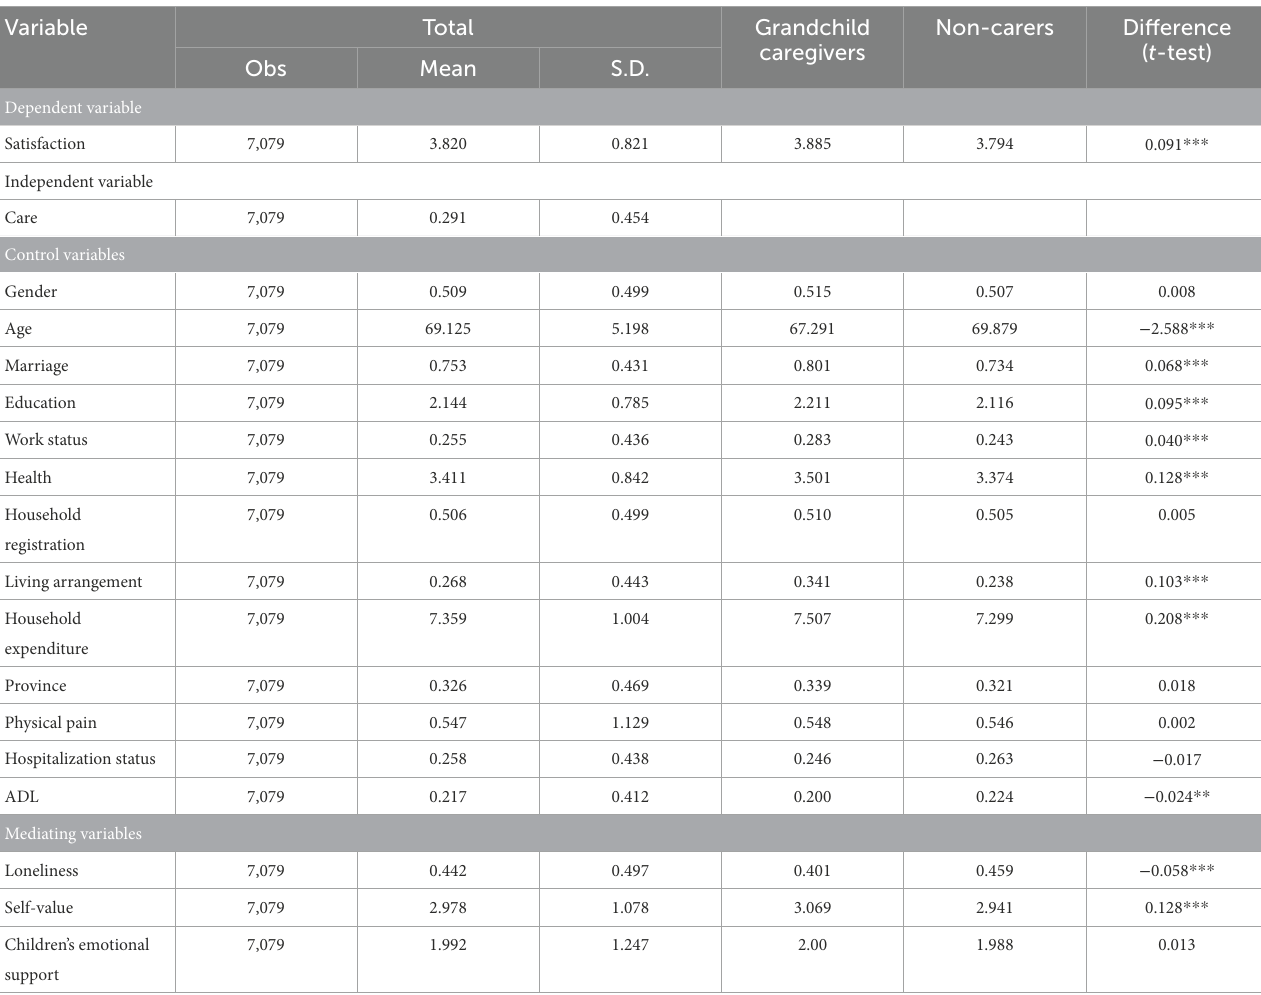
TABLE 1 Descriptive statistics